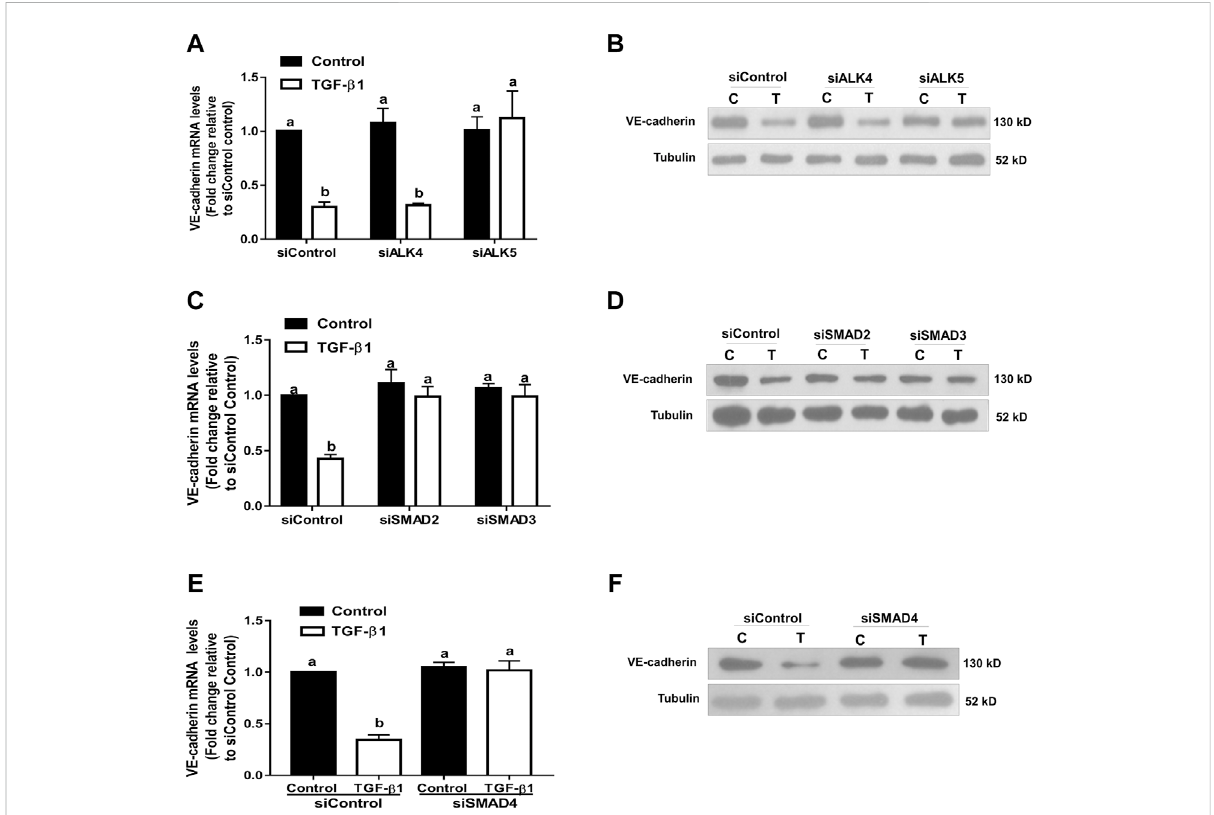
FIGURE 8 Effects of targeted depletion of ALK4, ALK5, SMAD2, SMAD3 and SMAD4 on the TGF- β 1-induced VE-cadherin downregulation in SVOG cells. Cellsweretransfectedwith25 nMsiControl,siALK4, siALK5 (A,B) ,siSMAD2,siSMAD3 (C,D) orsiSMAD4 (E,F) for24 handtreatedforfurther24 hwith a vehicle control or TGF- β 1 (10 ng/ml). The expression levels of VE-cadherin were examined by RT-qPCR and western blotting, respectively. Values labeled with different letters are signi fi cantly different ( p < 0.05), n = 3. (C) control; T, TGF- β